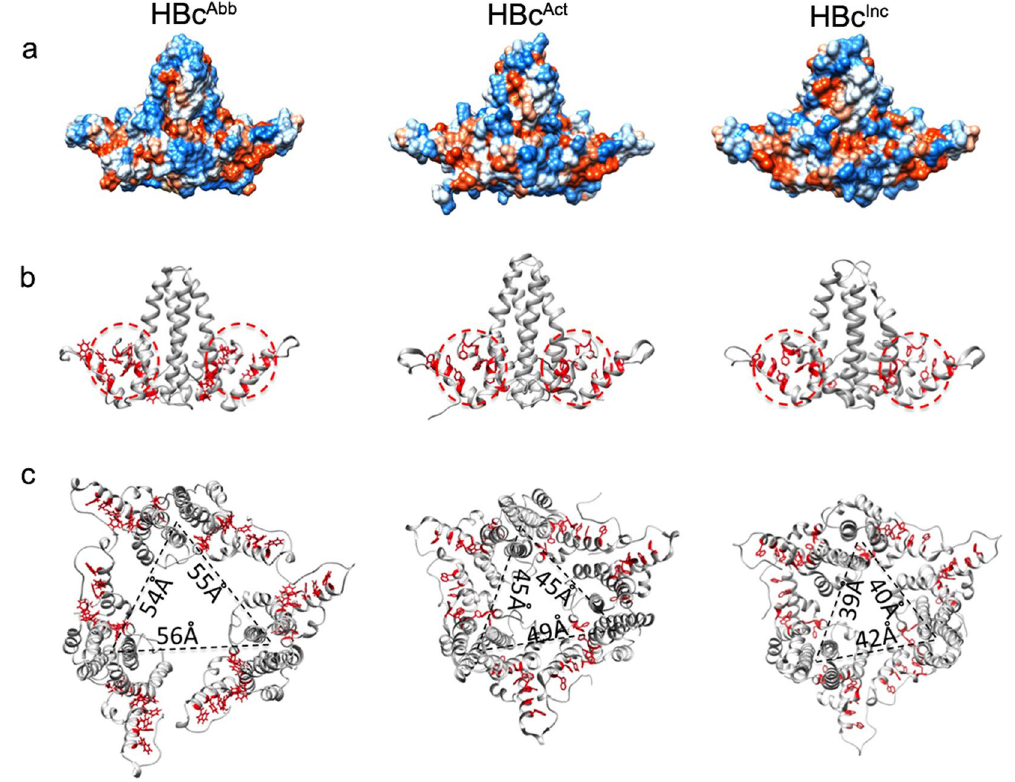
Figure 5. Structural features of HBc dimers in tube, capsid and sheet-like ensemble. ( a ) Structural models of dimers in tube (left), capsid (middle) and sheet-like ensemble (right), displayed as space-filled models with hydrophilic and hydrophobic residues rendered blue and red respectively, or ( b ) depictured as grey ribbon models with hydrophobic residues in helix α 5 and helix α 1 displayed as red sticks. ( c ) The trimers of dimers in the unit cell/asymmetric unit of HBc tube, capsid and sheet-like ensemble are displayed as grey ribbon models with hydrophobic residues in helix α 5 and helix α 1 displayed as red sticks. The three inter-dimer distances within the trimer of dimers of tube, capsid and sheet-like ensemble are